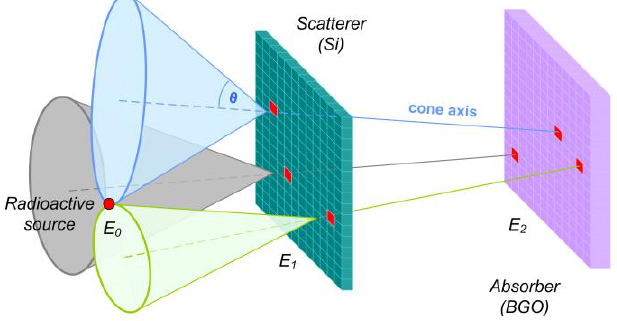
Fig. 3. Compton events with at least two simultaneous interactions within the detector. The conic probabilities define ellipses on a plane. The red dot in the intersection of those ellipses represents the radioactive source